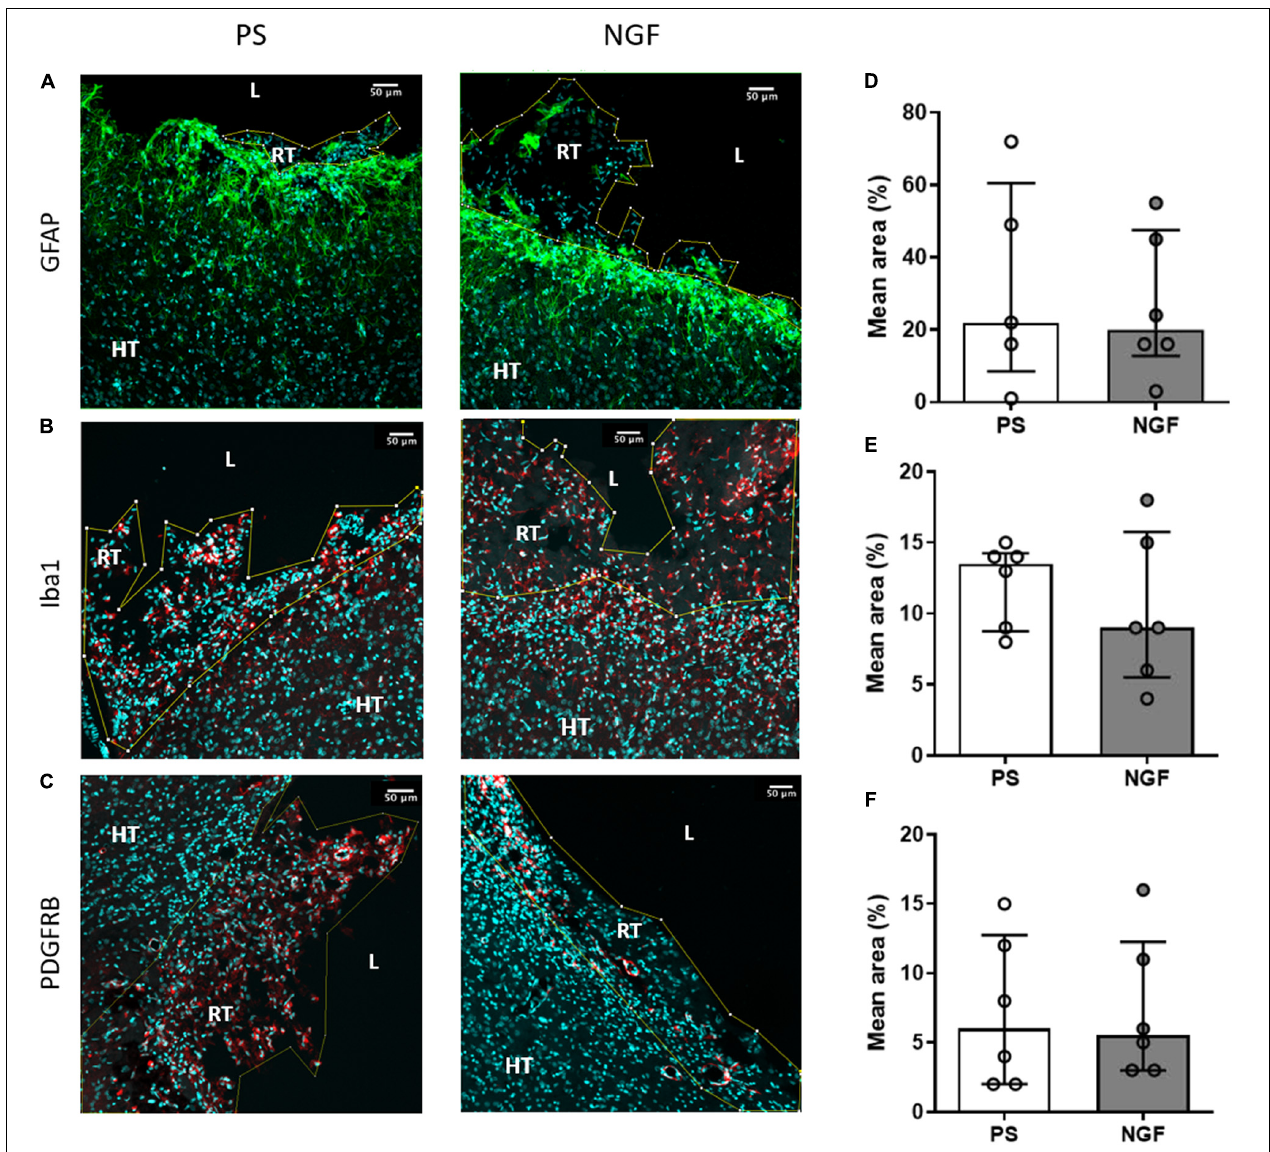
FIGURE 3 | Histology of brain sections and characterization of the reconstructed tissue and edge of the lesion: glio- and angiogensesis. Representative images and quantification of GFAP (A,D) , Iba1 (B,E) and PDGFRB (C,F) mean intensity in PS ( left ) and NGF ( middle ) groups. There was no significant difference between the groups, as reported in the graphs (D–F) . All the graphs show the distribution of individual values and the median and the interquartile range. PS group: n = 6; NGF group: n = 7 Scale bars: 50 µ m. PS: physiological saline; NGF: nerve growth factor; GFAP: glial fibrillary acidic protein; PDGFRB: platelet-derived growth factor receptor beta; L: lesion; RT: reconstructed tissue; HT: healthy